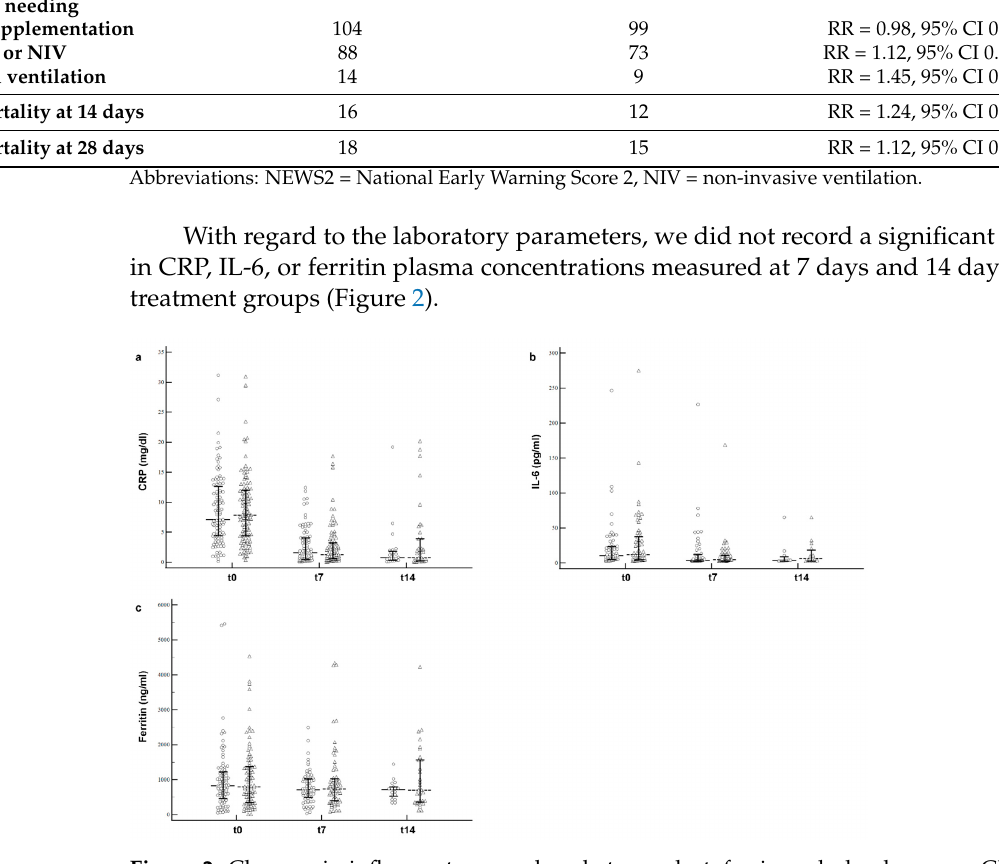
Figure 2. Changes in inflammatory markers between lactoferrin and placebo arms. CRP ( a ), IL ‐ 6 ( b ), and ferritin ( c ) plasma levels measured at different time points (t0, t7, t14). Circles represent the placebo arm, while triangles represent the lactoferrin one. Data are reported as median values (dashed lines) and interquartile range (bold lines). A subgroup analysis of subjects 65 years or older vs. those younger than 65 years and of females vs. males failed to reveal any effects of lactoferrin on primary outcomes (Table 5). Table 5. Lactoferrin effectiveness in driving disease evolution towards primary endpoints according to age subgroup and gender.